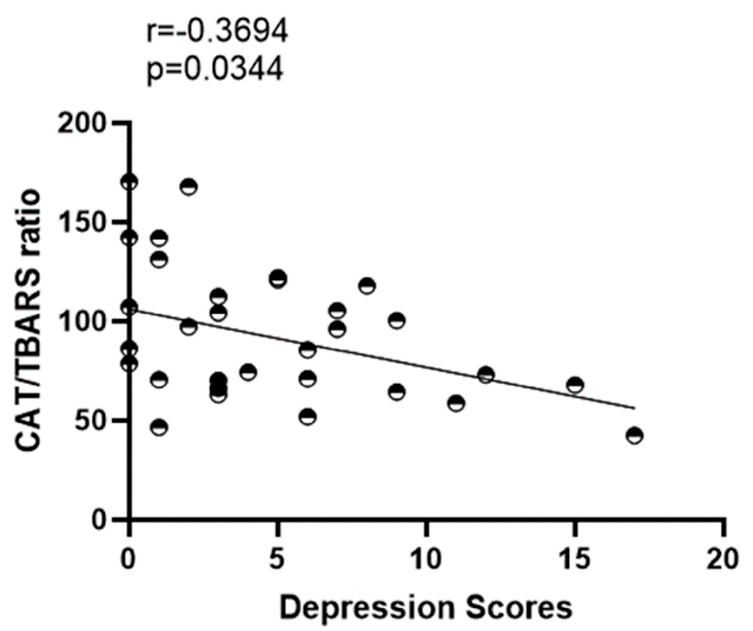
Figure 2. Correlation analysis among CAT/TBARS ratio and intensity of depression symptoms in master athletes.